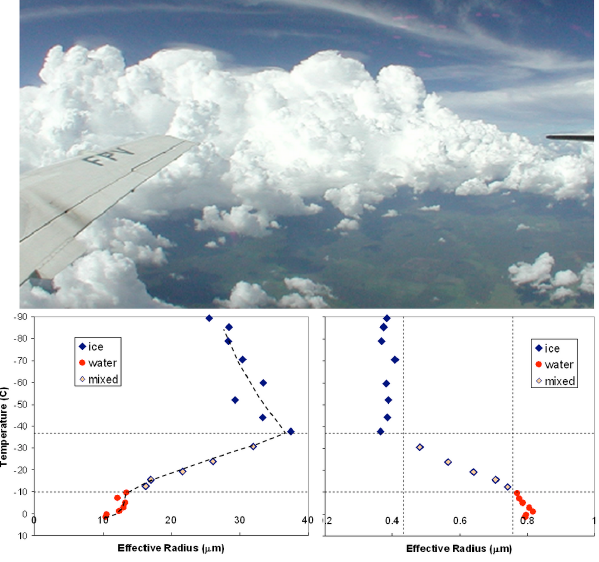
Fig. 7. Effective radius retrieved with radiances from the cloud side (bottom left plot) and separation between ice and water determined by the ratio between reflectances 2.10/2.25µm (bottom right plot) as a function of the vertical profile along the cloud side. The top image represents a wide field picture of the cloud system under